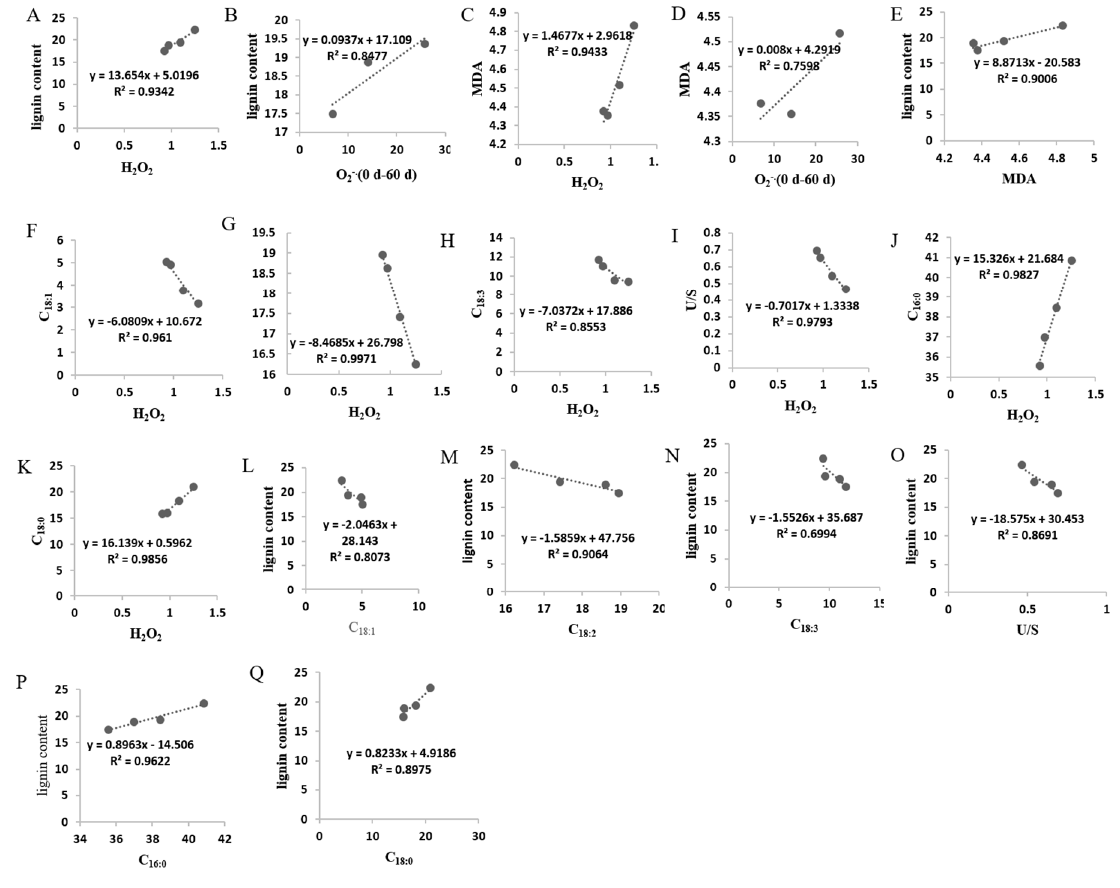
Figure 7. Correlationship between H 2 O 2 ( A ) and O 2 − (0–60 d) ( B ) with lignin; between H 2 O 2 ( C ) and O 2 − (0–60 d) ( D ) with MDA; between MDA with lignin ( E ); between H 2 O 2 with C 18:1 ( F ), C 18:2 ( G ), C 18:3 ( H ), USFA/SFA (U/S) ( I ), C 16:0 ( J ), and C 18:0 ( K ); and between C 18:1 ( L ), C 18:2 ( M ), C 18:3 ( N ), U/S ( O ), C 16:0 ( P ), and C 18:0 ( Q ) with lignin, in juice sacs of HR pomelo fruit. Cell membrane system is crucial in the normal physiological metabolism of fruit [70]. Lipids are